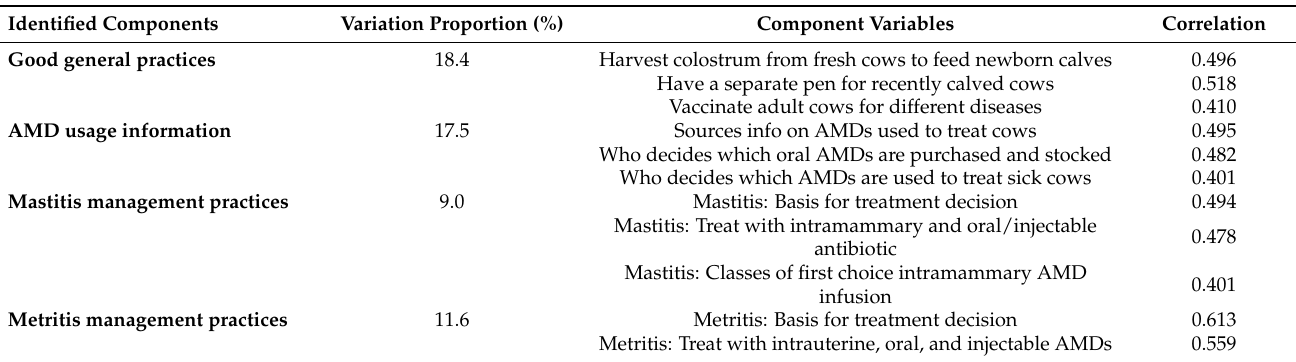
Table 8. Summary of multiple factor analysis of conventional dairies showing seven identified components extracted from 84 variables collected from 113 responses to a questionnaire on antimicrobial drug (AMD) use in adult cows on California dairies during